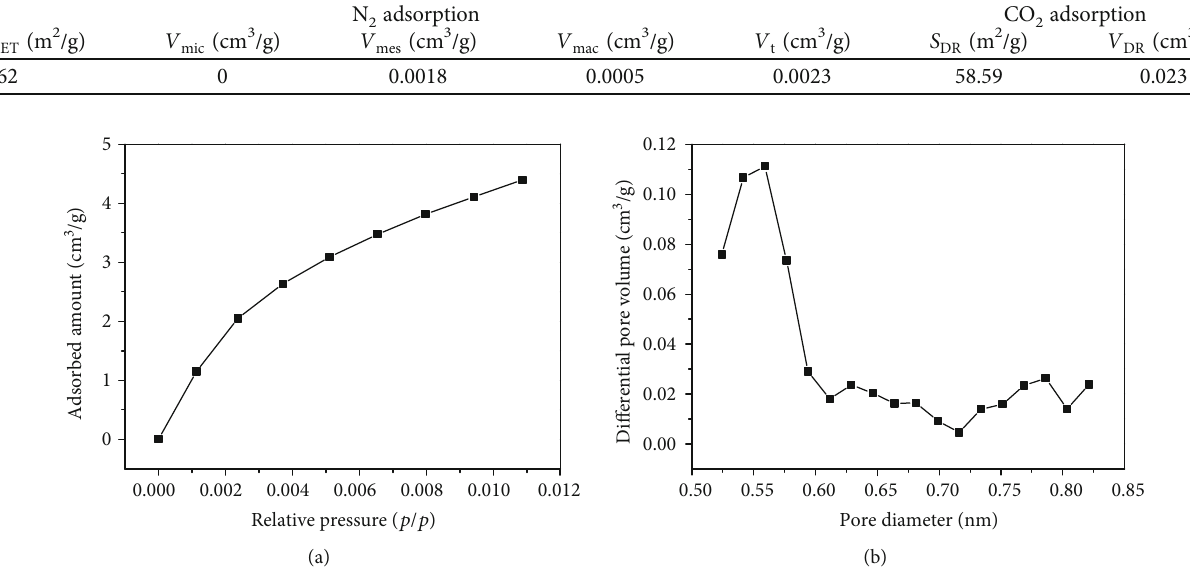
Table 1. The micropore size distribution of QS sample